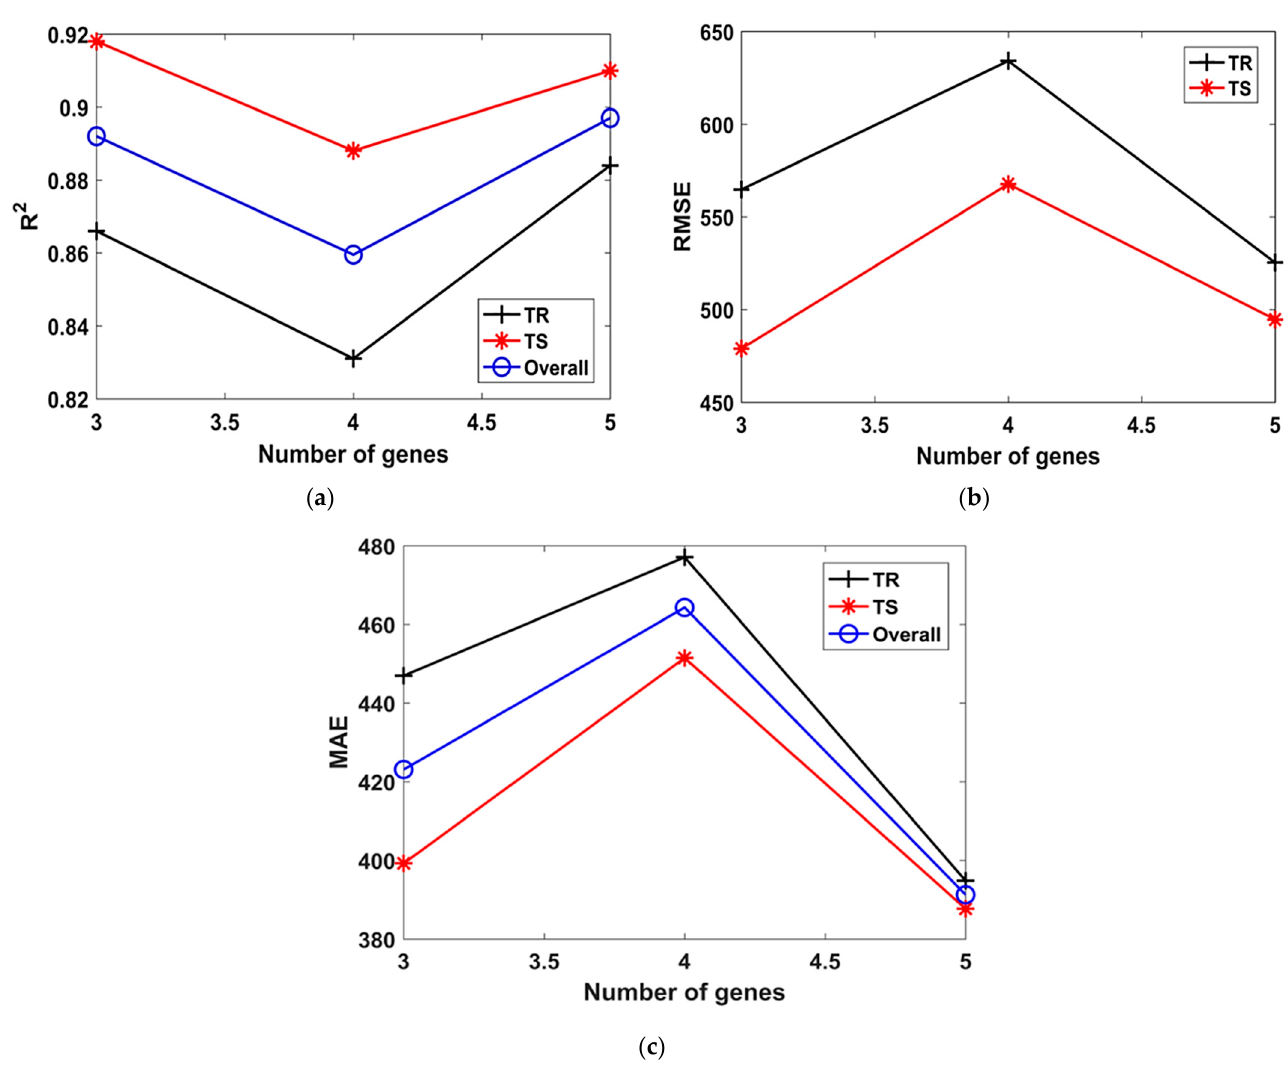
Figure 4. Effect of number of genes on the performance of models. ( a ) R 2 , ( b ) RMSE, ( c ) MAE.